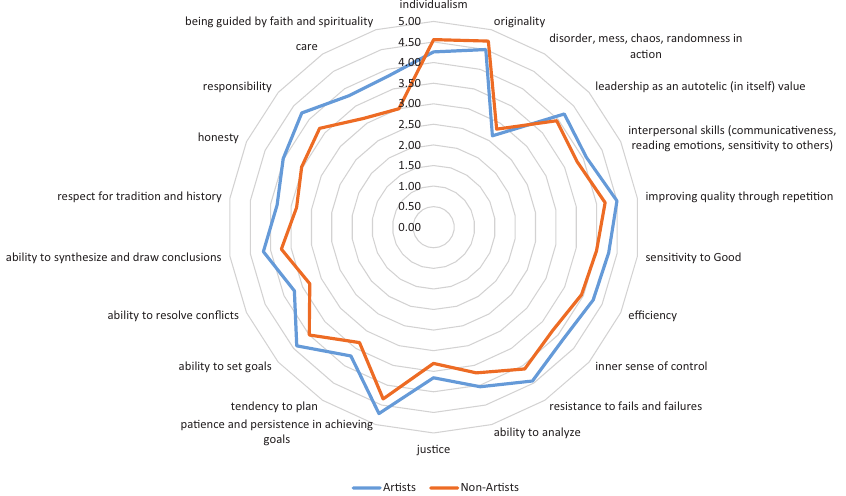
Figure 3. Perception of the most differently assessed features of an artist’s identity by artistic versus non-artistic individuals (source: created by